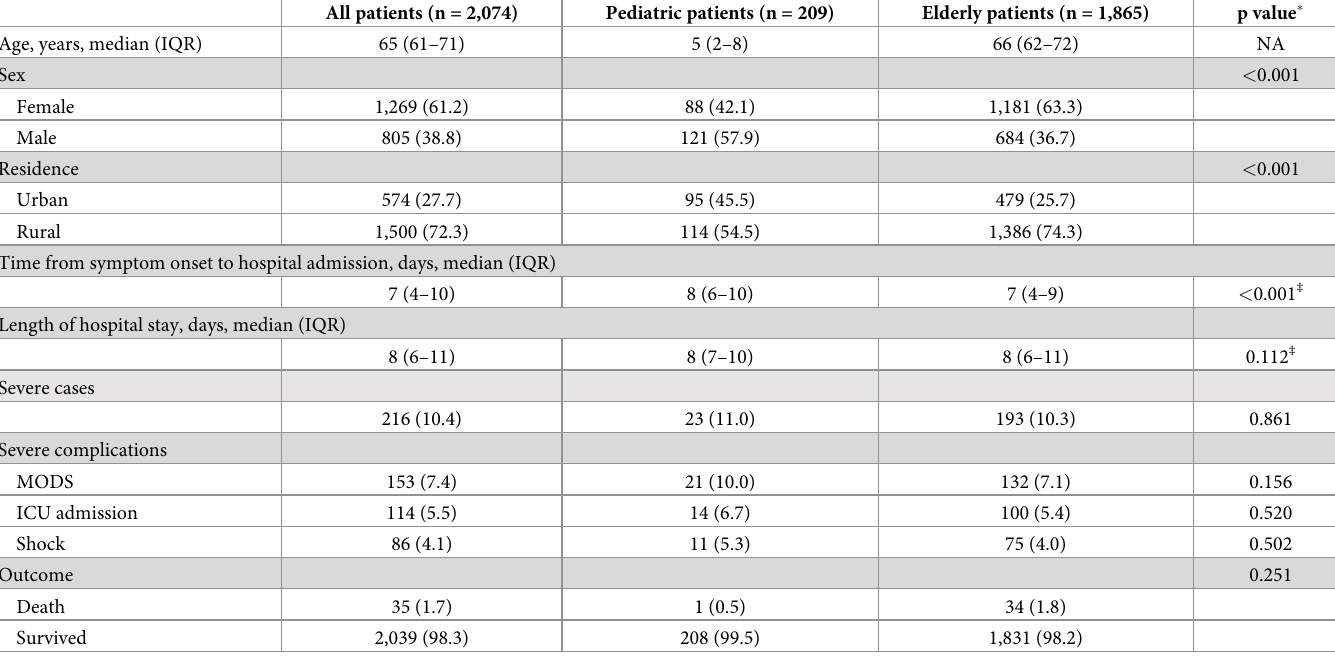
Table 1. Demographic and clinical characteristics compared between pediatric and elderly patients with scrub typhus.